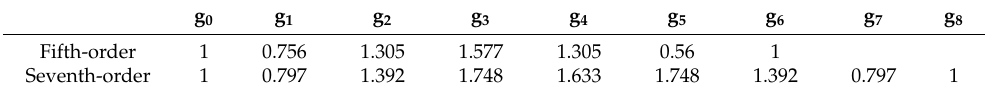
Figure 4. Low-pass filter equivalent circuit: ( a ) fifth-order Chebyshev low-pass filter and ( b ) seventh- order Chebyshev low-pass filter. Table 2. The fifth- and seventh-order Chebyshev response coefficient.